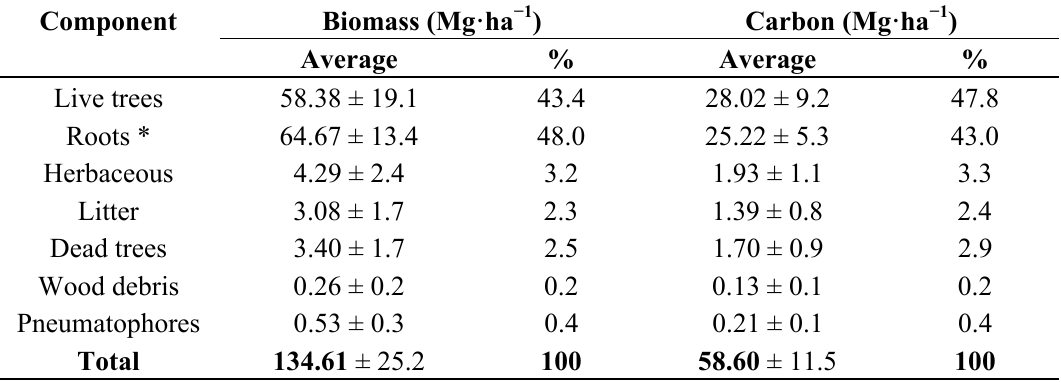
Table 2. Above-ground biomass and carbon pools (Mg·ha − 1 ) in the mangrove at Sofala Bay.